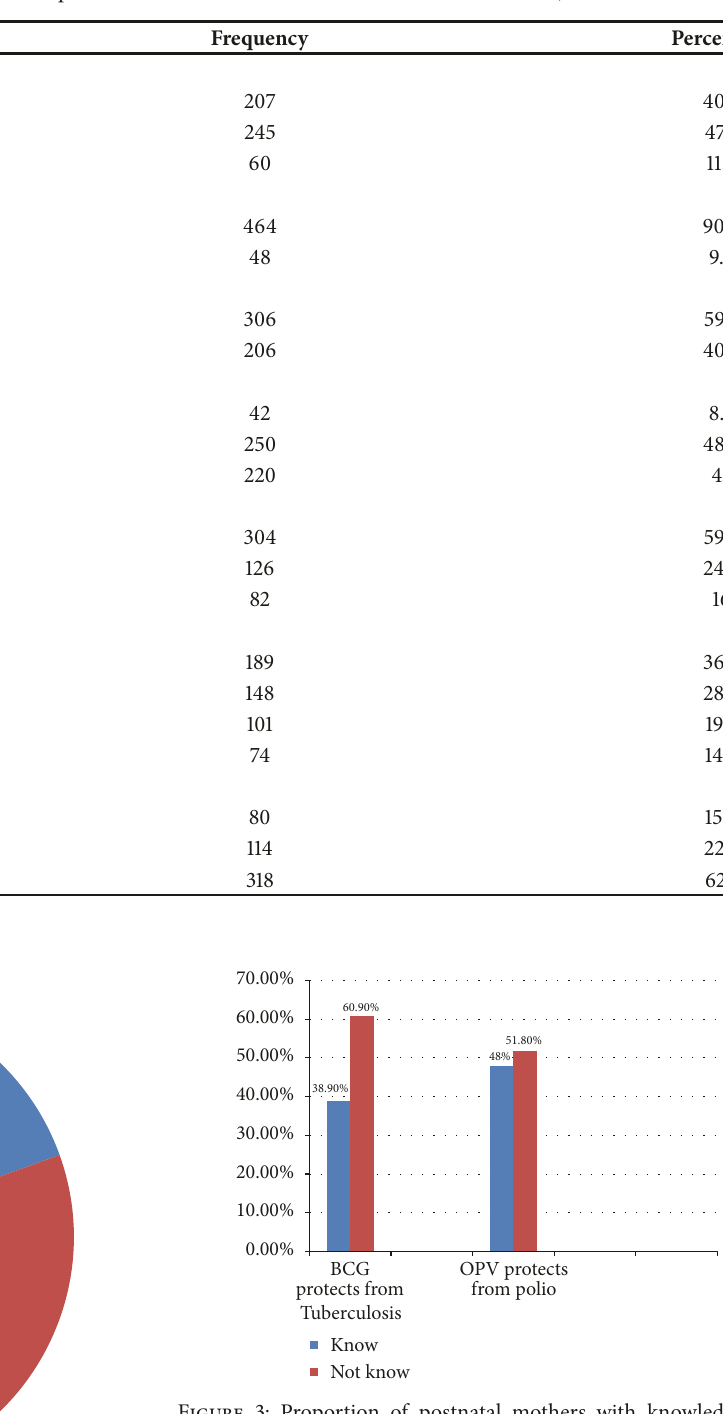
Figure 3: Proportion of postnatal mothers with knowledge on vaccines given at birth in Addis Ababa health centers, Dec. 1-Jan. 30, 2017.